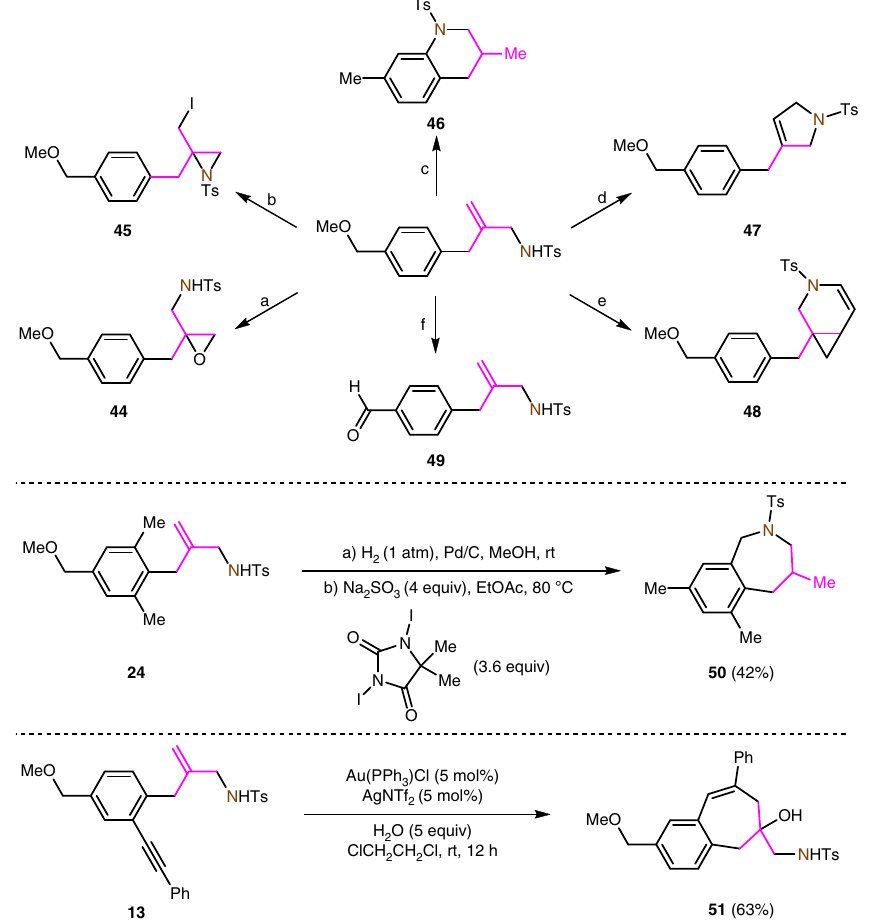
Fig. 6 Synthetic applications of the TMM insertion products. a) m -CPBA (6 equiv), CH 2 Cl 2 , 25 °C, 58%; b) NaI (1.2 equiv), t -BuOCl (1.2 equiv), MeCN, 25 °C, 50%; c) i. H 2 (1 atm), Pd/C, MeOH, 25 °C, 95%, ii. 1,3-diiodo-5,5-dimethylimidazolidine-2,4-dione (1.8 equiv), Na 2 SO 3 (2 equiv), ClCH 2 CH 2 Cl, 60 °C, 83%; d) i. 3-bromoprop-1-ene (1.2 equiv), K 2 CO 3 (2 equiv), MeCN, 80 °C, 76%, ii. Grubbs catalyst II (4 mol%), CH 2 Cl 2 , rt, 80%; e) i. 3-bromoprop- 1-yne (1.2 equiv), K 2 CO 3 (2 equiv), MeCN, 80 °C, 80%, ii. PtCl 2 (4 mol%), toluene, 80 °C, 67%; f) DDQ (6 equiv), CH 2 Cl 2 :H 2 O = 10:1, 25 °C, 78%. The pink part in the structures mean that it is an insertion